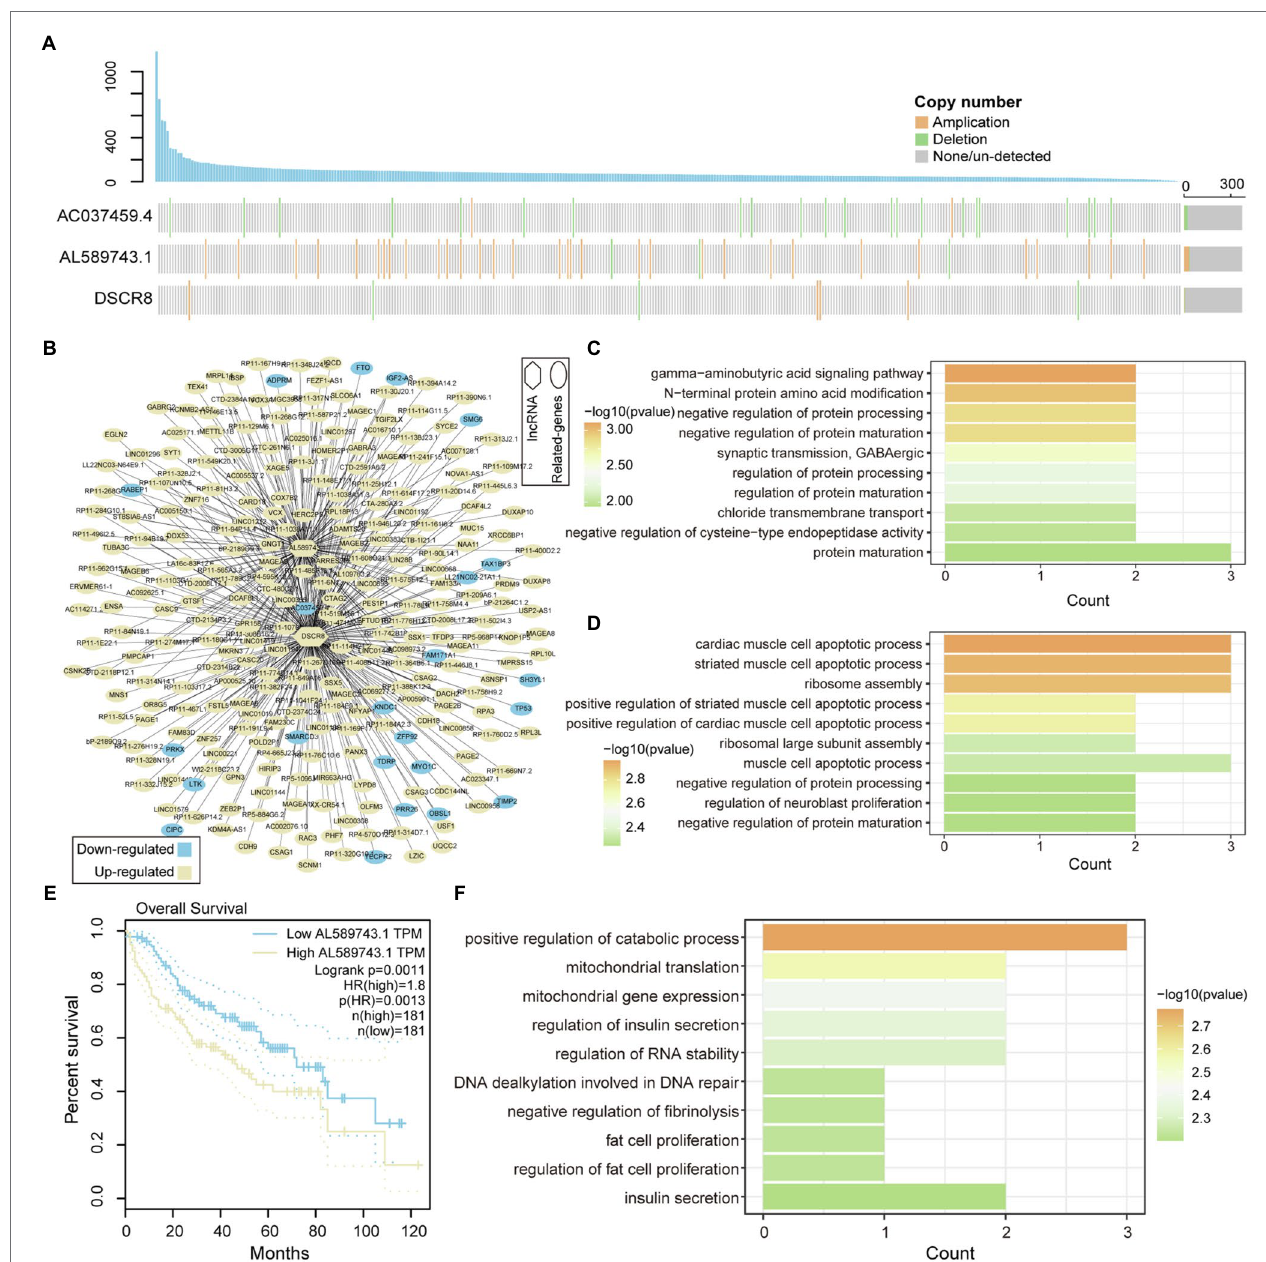
FIGURE 3 | Functional identification of mutation-driven lncRNA. (A) Waterfall plot illustrates variation types of copy number (amplification, deletion, and none/un- detected) for each sample on lncRNA, including AC037459.4, AL589743.1, and DSCR8. The up-panel shows the number of mutated genes in each sample. (B) The relationship between mutation-driven lncRNA and co-expressed genes is shown by network. Circles represent co-expressed genes with lncRNAs; squares represented mutation-driven lncRNAs. Upregulated genes are marked with yellow; downregulated genes are marked with blue. (C,D) The bar graphs show the GO function enrichment results for genes co-expressed with lncRNA AC037459.4 and AL589743.1. (E,F) Survival difference between the two groups of samples with high and low expression of AL589743.1 and DSCR8. Univariate cox regression algorithm and log-rank test are used to evaluate the relationship between the expression of Md-lncRNA and patient